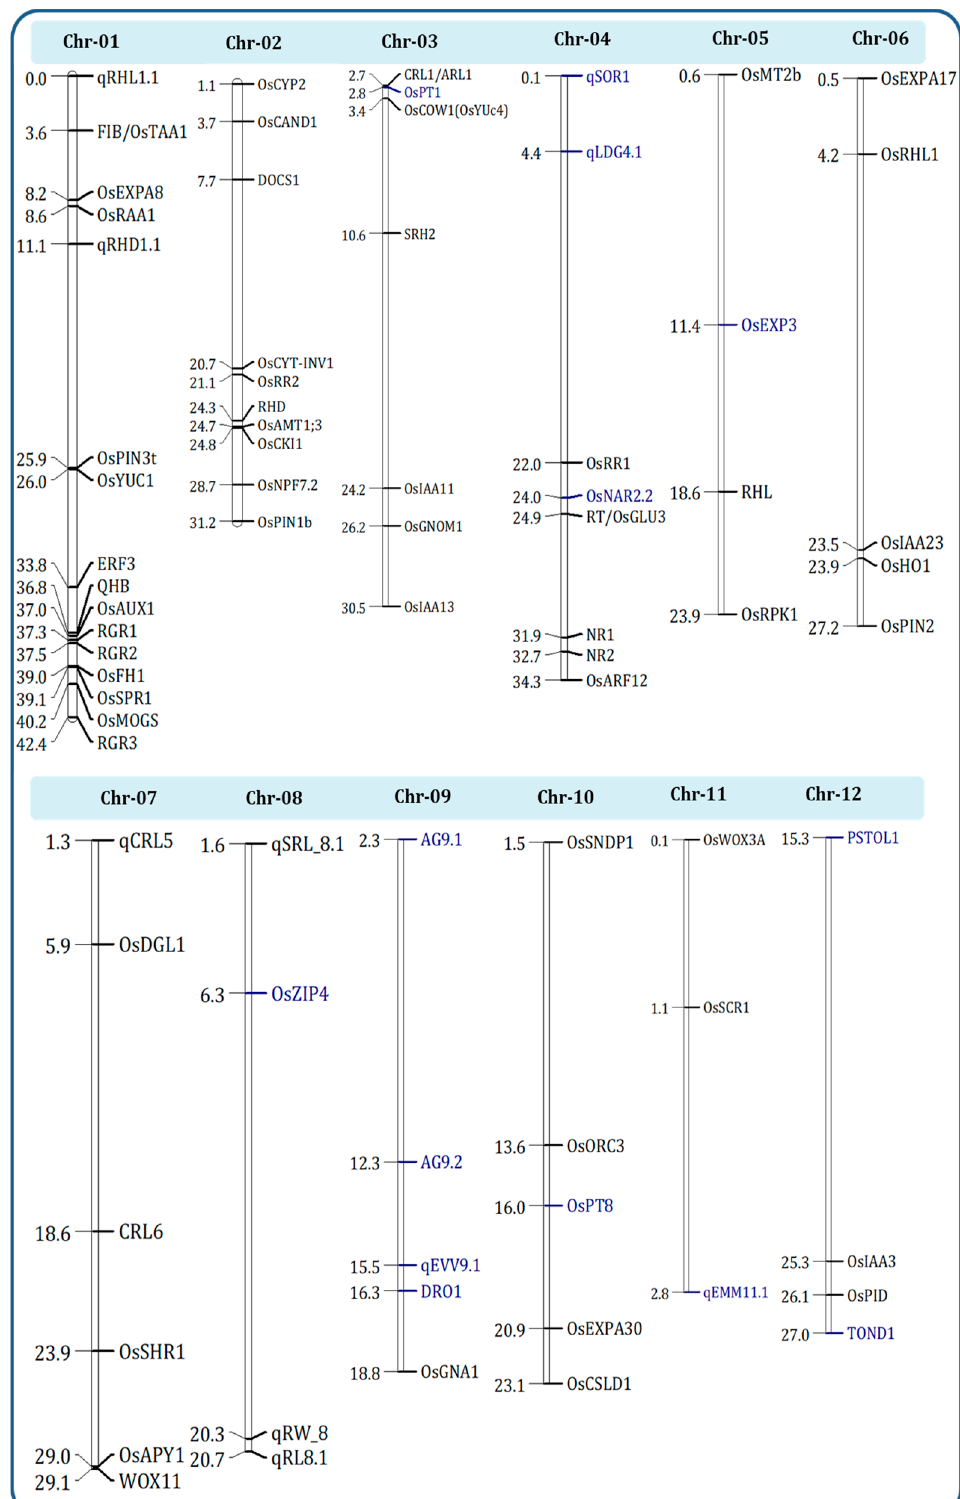
Figure 4. Depicted diagram of the genomic regions of root system architecture (RSA) traits associated with QTLs and genes in all chromosomes. The left bar numeric values indicate the genomic position (in Mb), and the names of QTLs and genes are on the right side. The blue color represents the important QTLs and genes used in improving RSA traits in DSR conditions, whereas the black color represents the QTLs and genes collected from the comprehensive literature survey on RSA traits under DSR conditions.